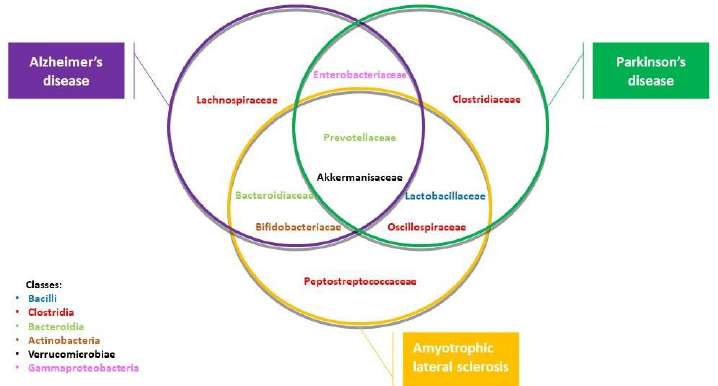
Figure 2. Illustration of bacteria and prokaryotic domains implicated in Alzheimer’s disease (AD), Parkinson’s disease (PD), and amyotrophic lateral sclerosis (ALS). Note how the Akkermansiaceae and Prevotellaceae families are both implicated in these three diseases; the Lactobacillaceae and Oscillospiraceae families are involved in PD and ALS; the Bacteroidiceae and Bifidobacteriaceae families are implicated in AD and ALS, while the Enterobacteriaceae family is involved in AD and PD. The Lachnospiraceae, Peptostreptococcaceae and Clostridiaceae families are involved in AD, ALS, and PD.